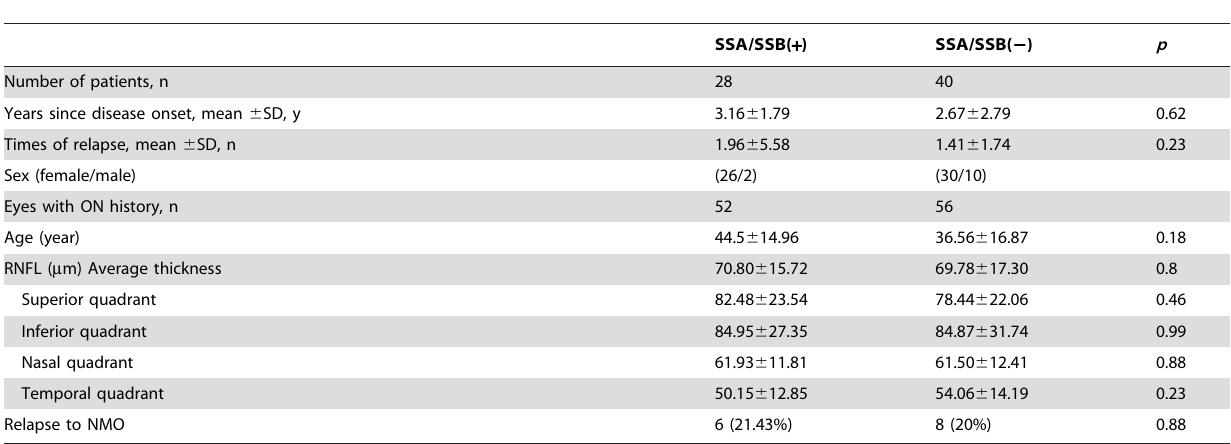
Table 6. Differences between patients with positive SSA/SSB and negative